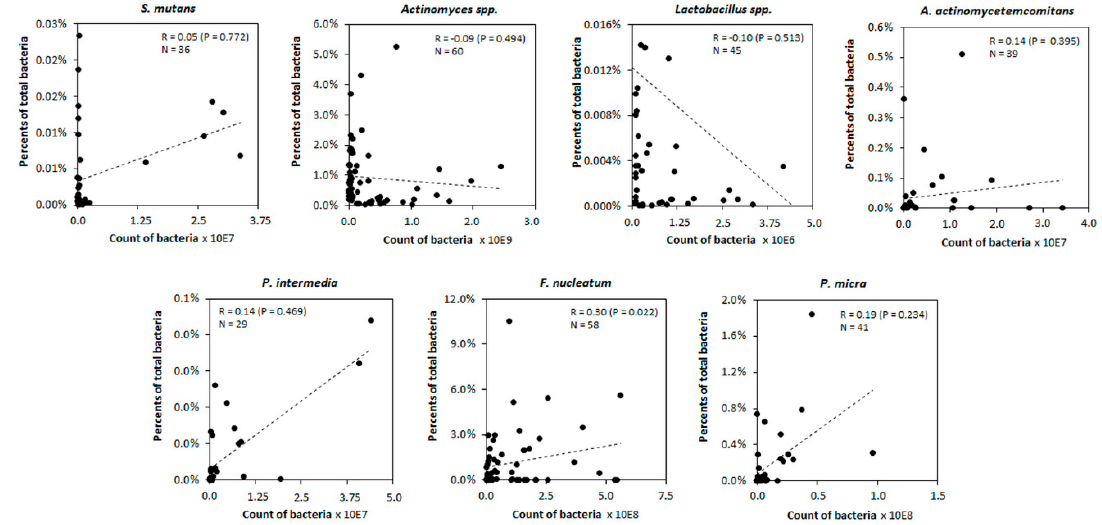
Figure 2. Correlation plots between the counts of bacteria and their percentage content in samples. Exceptional values in Lactobacillus spp. and A. actinomycetemcomitans were omitted from the analysis. Black dots correspond to individual analyzed samples and dotted line shows trend line on a scatter plot.